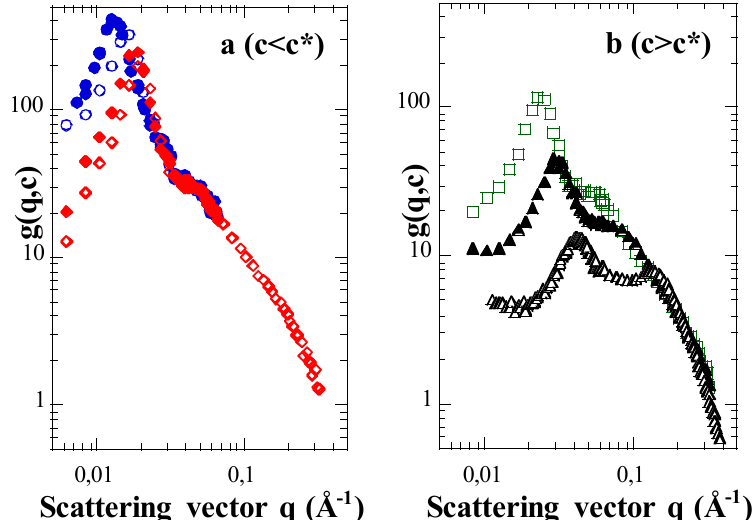
Figure 1. Scattering functions of NaPSS star solutions in the dilute and semi-dilute regimes. ( a ) S100-S91/D 2 O in the dilute regime ( c < c * ≈ 0.075 mol·L − 1 – φ < φ * ≈ 0.83%); c = 0.013 mol·L − 1 – φ = 0.14% (dotted circles); c = 0.025 mol·L − 1 – φ = 0.28% (circles); c = 0.038 mol·L − 1 – φ = 0.42% (dotted lozenges); c = 0.052 mol·L − 1 − φ = 0.58% (lozenges); ( b ) S100-S91/D 2 O in the semi-dilute regime ( c > c *); c = 0.102 mol·L − 1 − φ = 1.13% (squares); c = 0.258 mol·L − 1 − φ = 2.87% (dotted triangles); c = 0.754 mol·L − 1 − φ = 8.39% (triangles).